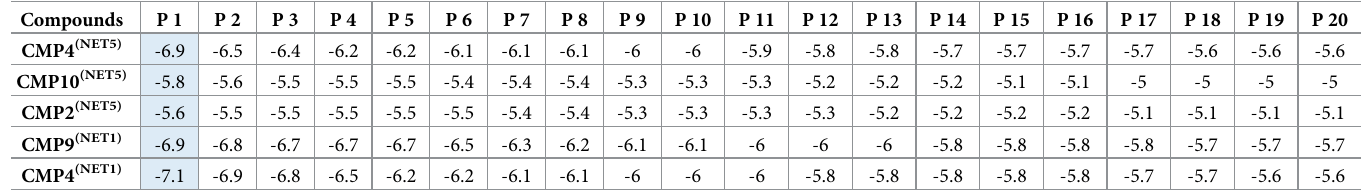
Table 5. Binding energies (kcal/mole) calculated by AutoDock for the top 20 poses generated in docking of top 5 hits with 3CL protease.